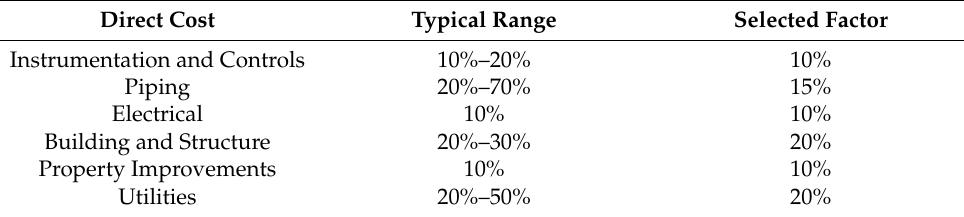
Table 2. Other direct costs